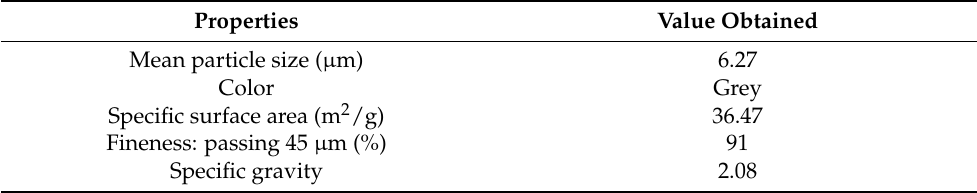
Table 4. Physical properties of rice hush ash.